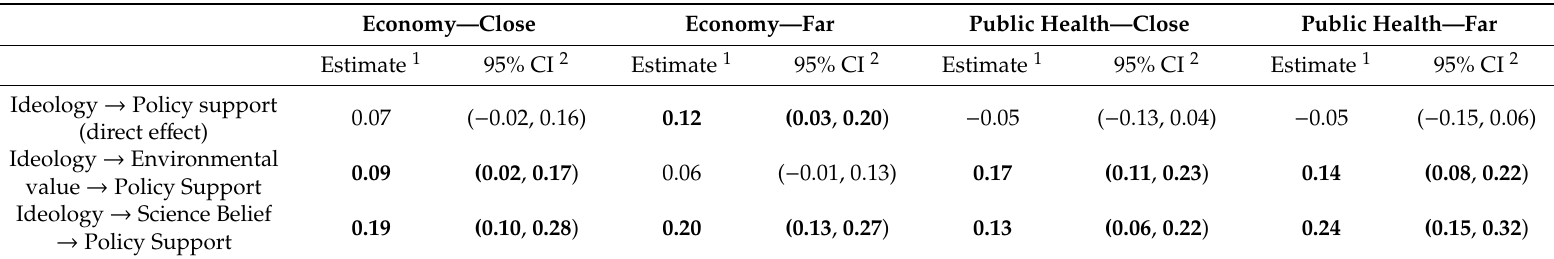
Table 5. Direct and indirect e ff ects of ideology on policy support in four experimental conditions (unstandardized regression coe ffi cients). Economy—Close Economy—Far Public Health—Close Public